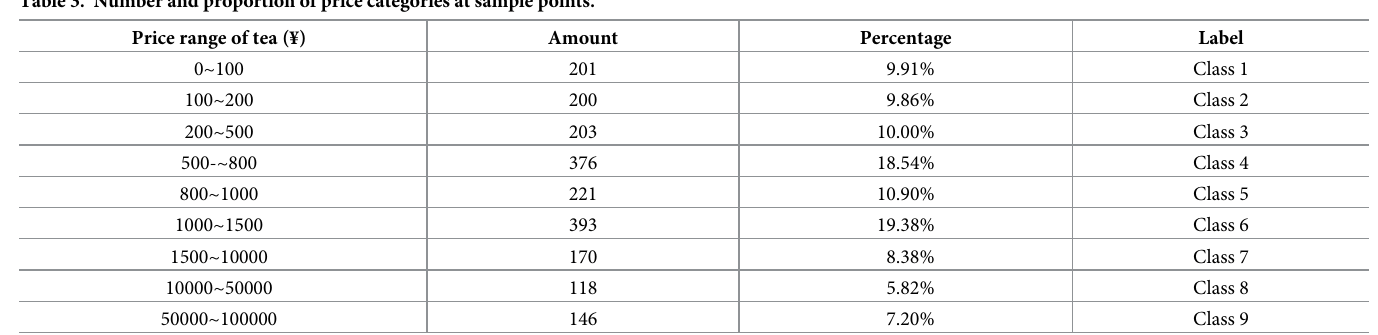
Table 3. Number and proportion of price categories at sample